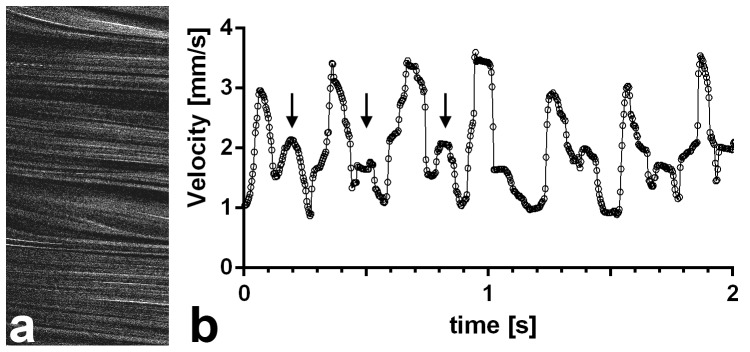
THG line scan measurement of the blood flow velocity in the tail artery of a stage 45 Xenopus laevis larvae (4 days post fertilization).(a) xt-representation showing 680 lines of the recording, representing the first 0.46 s of the graph in (b). (b) LS-PIV results from the two seconds depicted show values oscillating between 4 mm/s systolic and 0.9 mm/s diastolic. The higher peaks are determined by ventricular heart contractions. Arrows mark the first three secondary peaks (see main text). Calculation of the heart rate yielded a value of about 200 beats per minute, the vessel diameter was 45 µm.